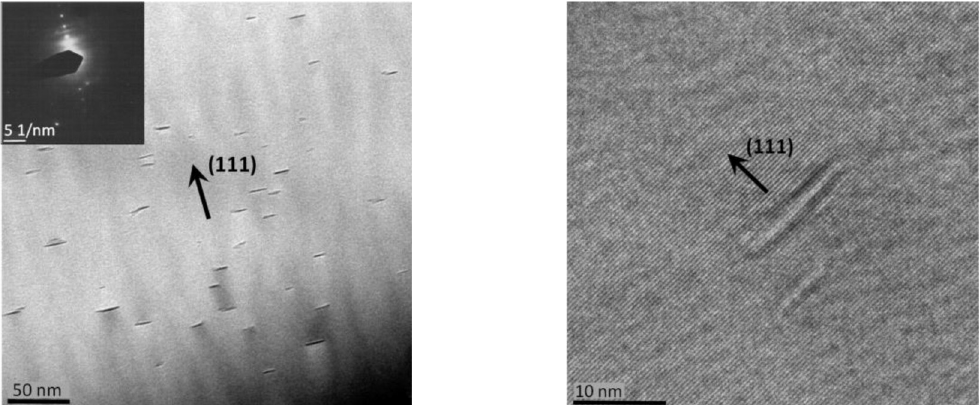
Fig. 11. 4 He implanted in B 4 C then annealed at 1100 ° C. Left: parallel plate-like intra-granular bubbles band with strain fi elds and the corresponding diffraction pattern. Right: two oriented bubbles in high resolution